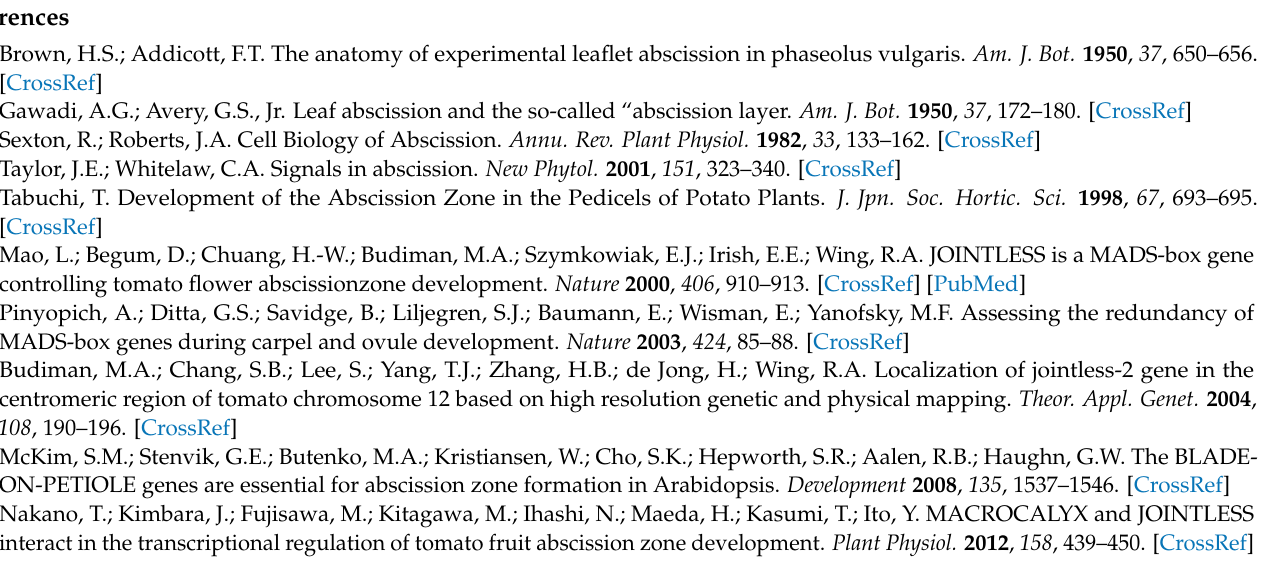
terms. Figure S1. The enrichment analysis for genes involved in the plant hormone pathways during pedicel AZ development in tomatoes. Figure S2. The enrichment analysis of the DEGs belonging to different classes of auxin response